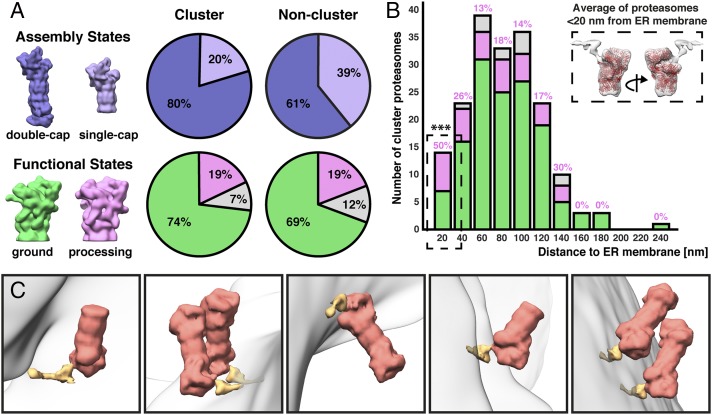
Analysis of proteasome states within degradation microcompartments. (A) Comparison of assembly state and functional state frequencies between the cluster and noncluster cytosolic proteasomes. Cluster proteasomes have a higher percentage of double-capped (80%) compared to the cytosolic population (61%). For both populations, the majority of proteasome caps are in the ground state (69 to 74%). Double-capped, purple; single-capped, lavender; ground state, green; substrate-processing state, pink; unclassified, gray. (B) Functional states of cluster proteasome caps as a function of distance to the ER membrane. The percentages of processing caps are written in pink over each bar in the graph. Proteasomes <20 nm from ER have a significantly higher fraction of processing caps compared to the rest of the cluster proteasomes (for statistical test, see Methods). Subtomogram averaging of these ER-proximal proteasome caps reveals an extra density that likely corresponds to engaged substrate (dashed Inset, red: fitted proteasome molecular structure; see SI Appendix, Fig. S13 for evidence that the extra density is bound at the proteasome’s substrate engagement site). (C) Mapping each of the ER-proximal processing state proteasomes (red) back into the cellular volumes reveals that the extra density (orange) always connects to the ER membrane (gray), consistent with a putative substrate.